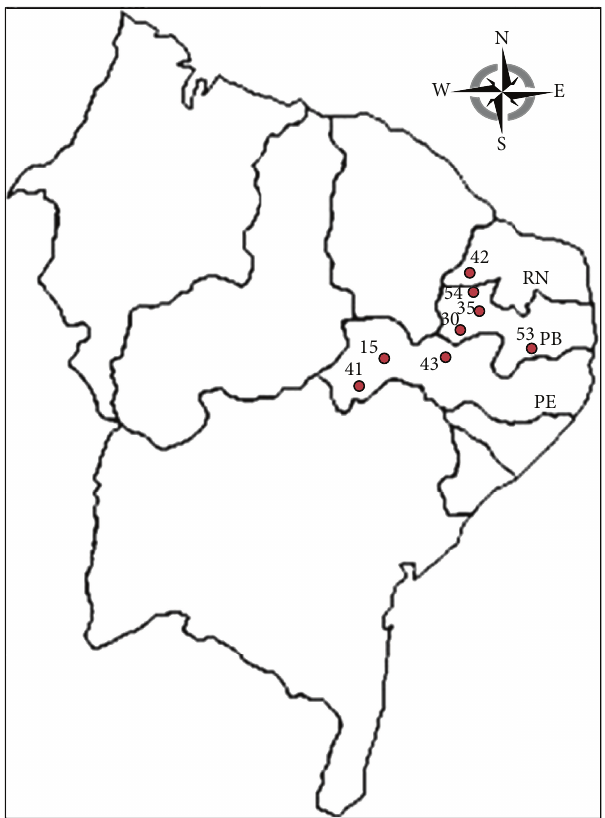
Figure 1: Map of northeast region of Brazil indicating the localities of the Triatoma brasiliensis populations studied. Para´ıba State: Monteiro (30), M˜ae d’´agua (35), Santa Cruz (54), and S˜ao Jos´e (53), S˜ao Francisco (55). Pernambuco State: Lagoa Grande (41),